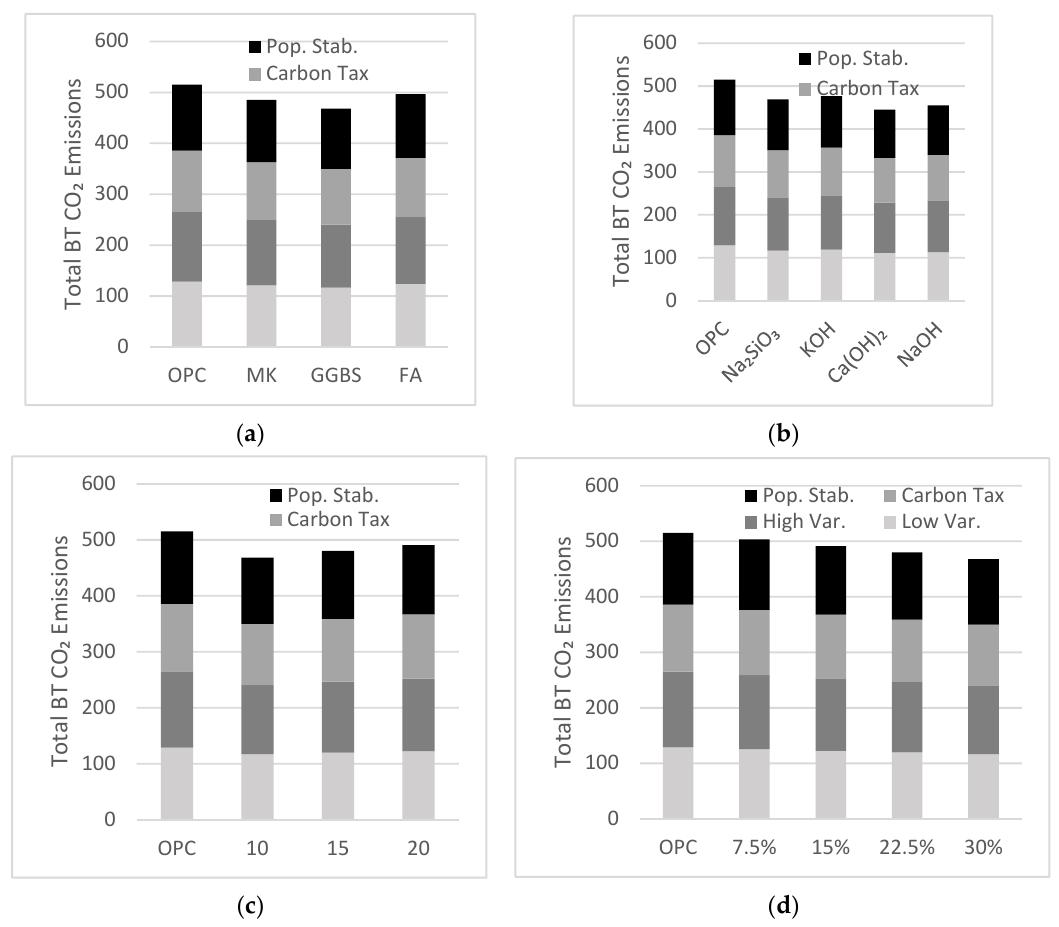
Figure 11. Sensitivity analysis exhibiting the effect of the ( a ) precursor type; ( b ) activator type; ( c ) policy implementation period; ( d ) AAB target market share demand in a Low Variability Scenario, High Variability Scenario, Carbon Tax Increase Scenario, Population Stabilization Scenario in the year 2050.